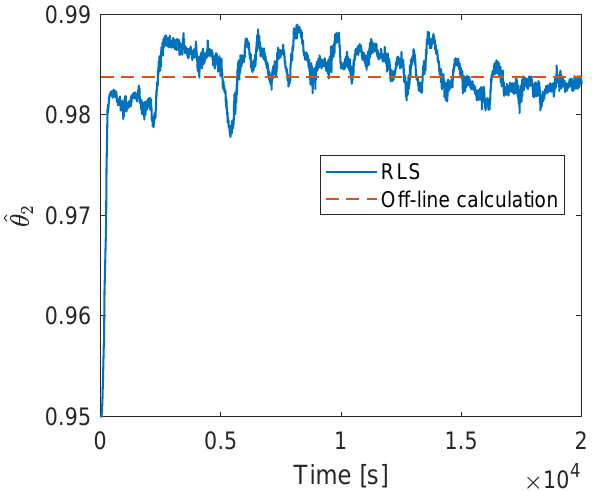
Figure 6. Comparison of the estimated results of parameter θ 2